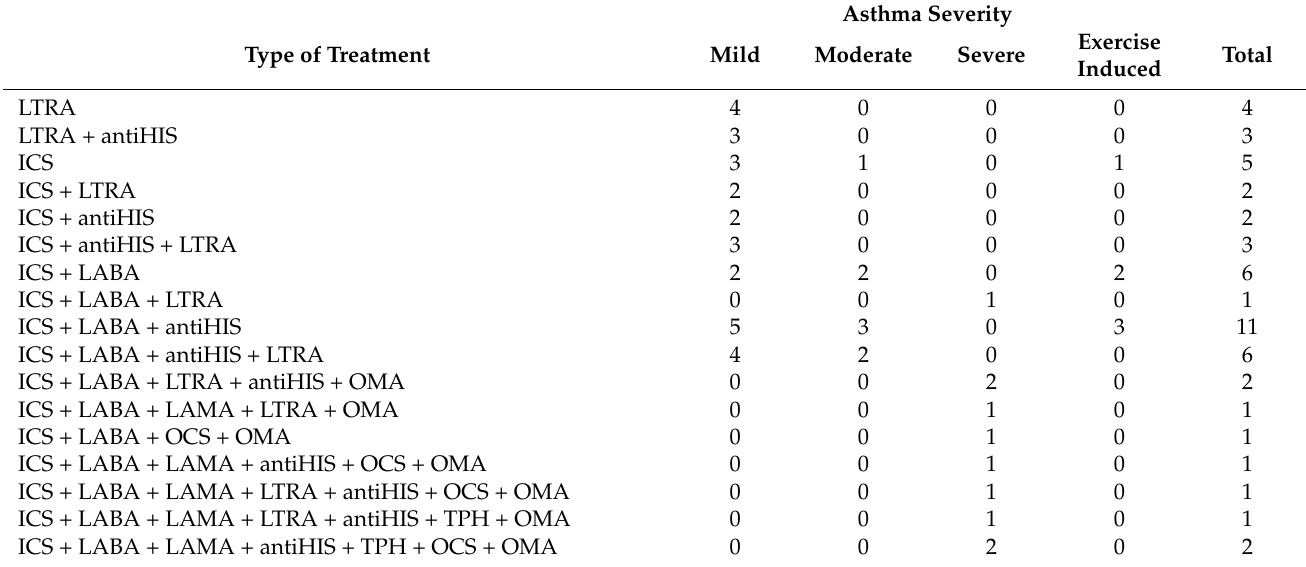
Table 3. Asthma treatment according to asthma